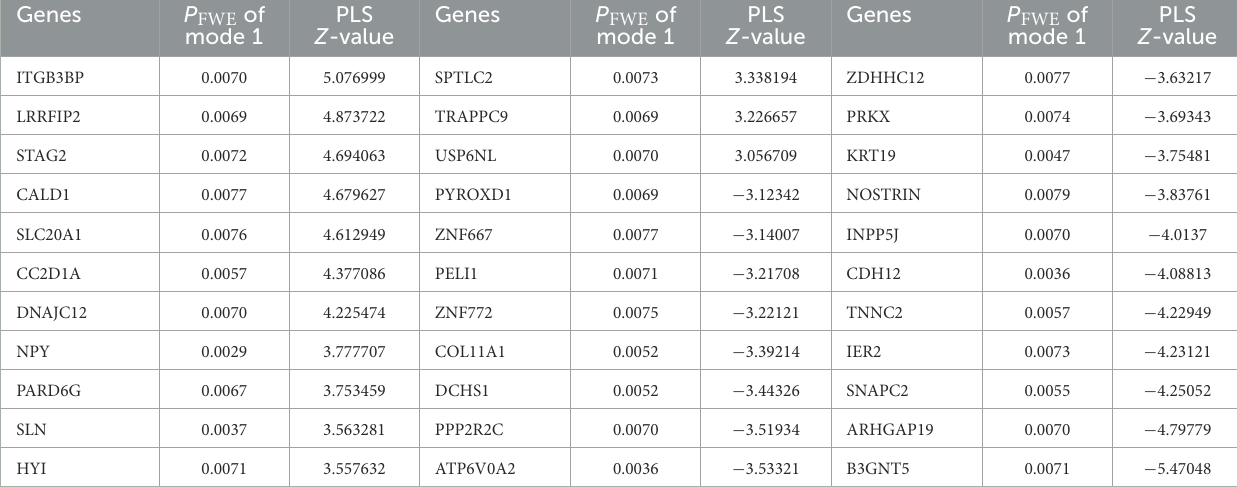
TABLE 1 Significant genes in the CCA analysis between longitudinal DNAm of PLS1 genes and patients’ reduction rate of clinical symptoms. Genes P FWE of PLS Genes P FWE of PLS Genes P FWE of PLS Z -value Z -value Z mode 1 mode 1 mode 1